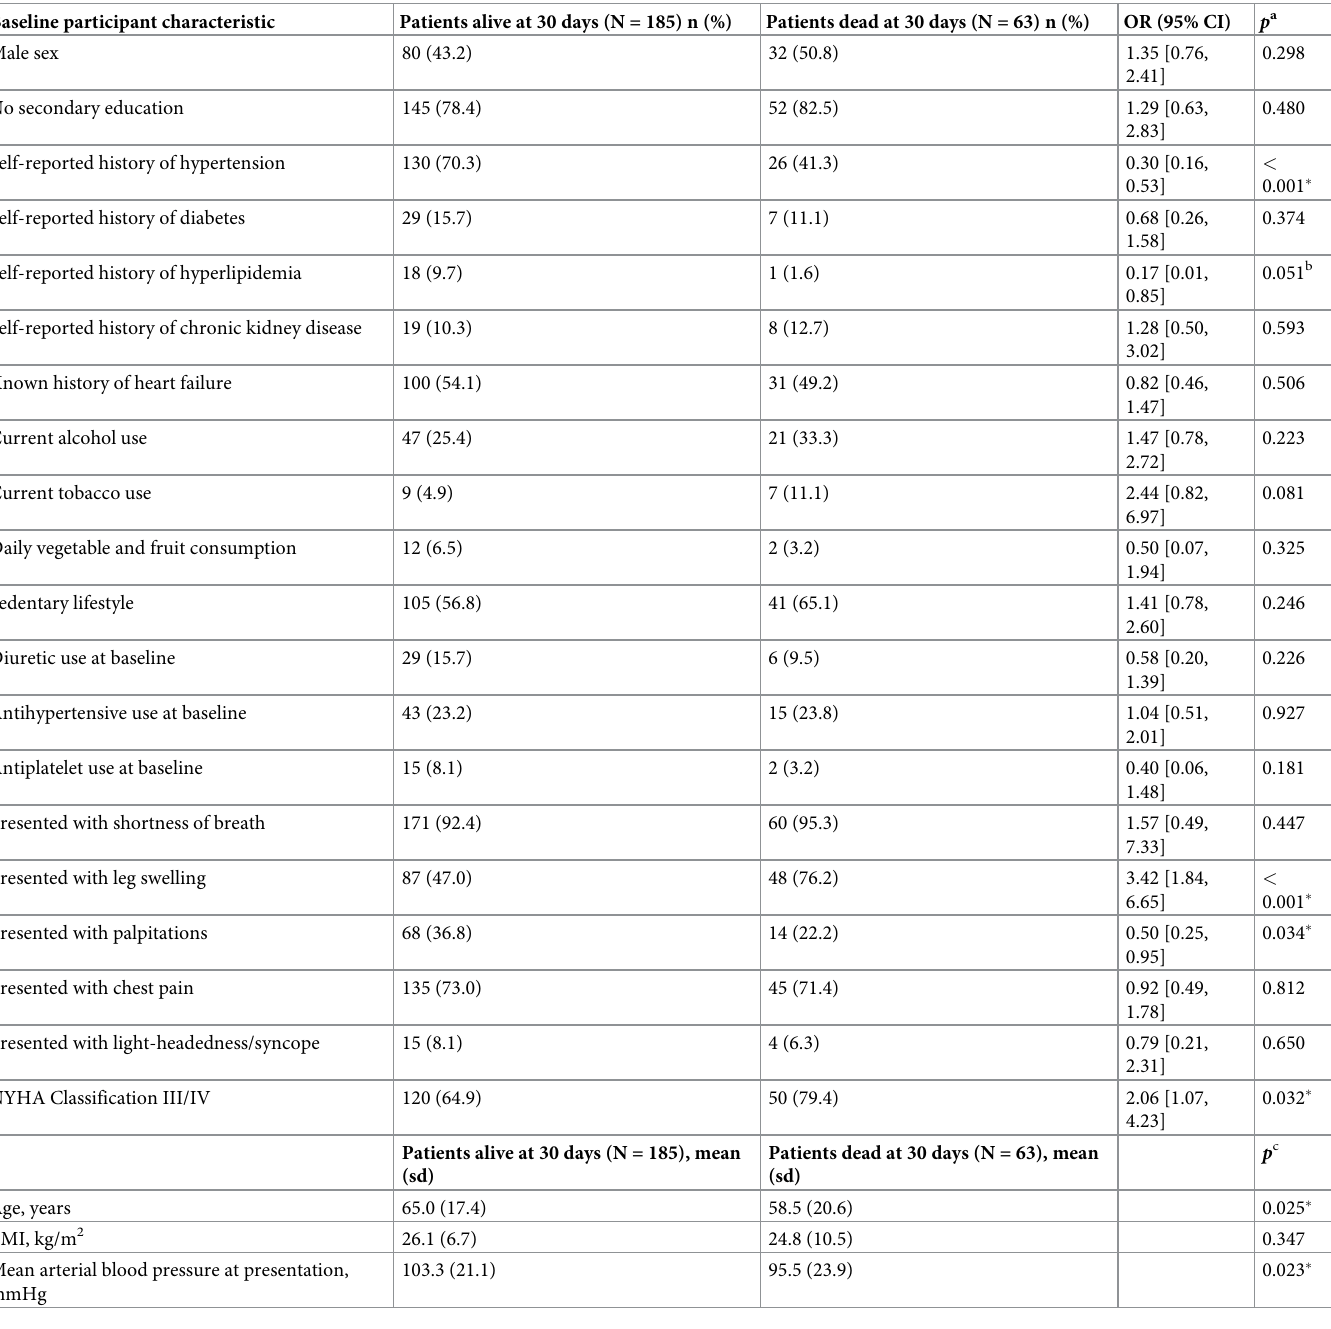
Table 4. Associations between baseline patient characteristics and thirty-day mortality following hospital diagnosis of heart failure, northern Tanzania, 2018–2019 (n =